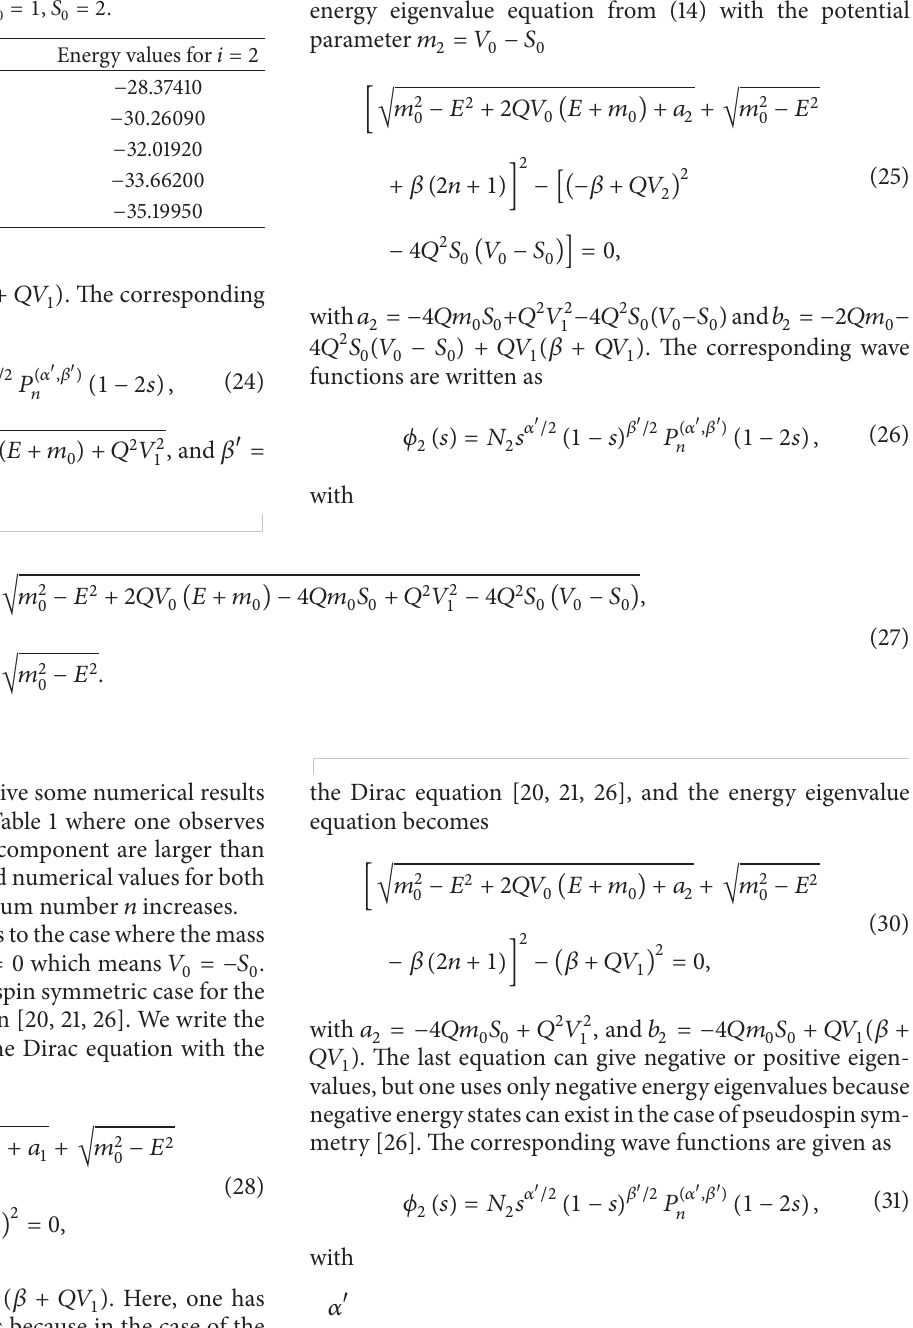
Table 1: The variation of energy eigenvalues with different 𝑛 for 𝛽 = = 50 , 𝑉 = 𝑉 = 1.5 , 𝑄 = 100 , 𝑉 1 , 𝑚 0 1 2